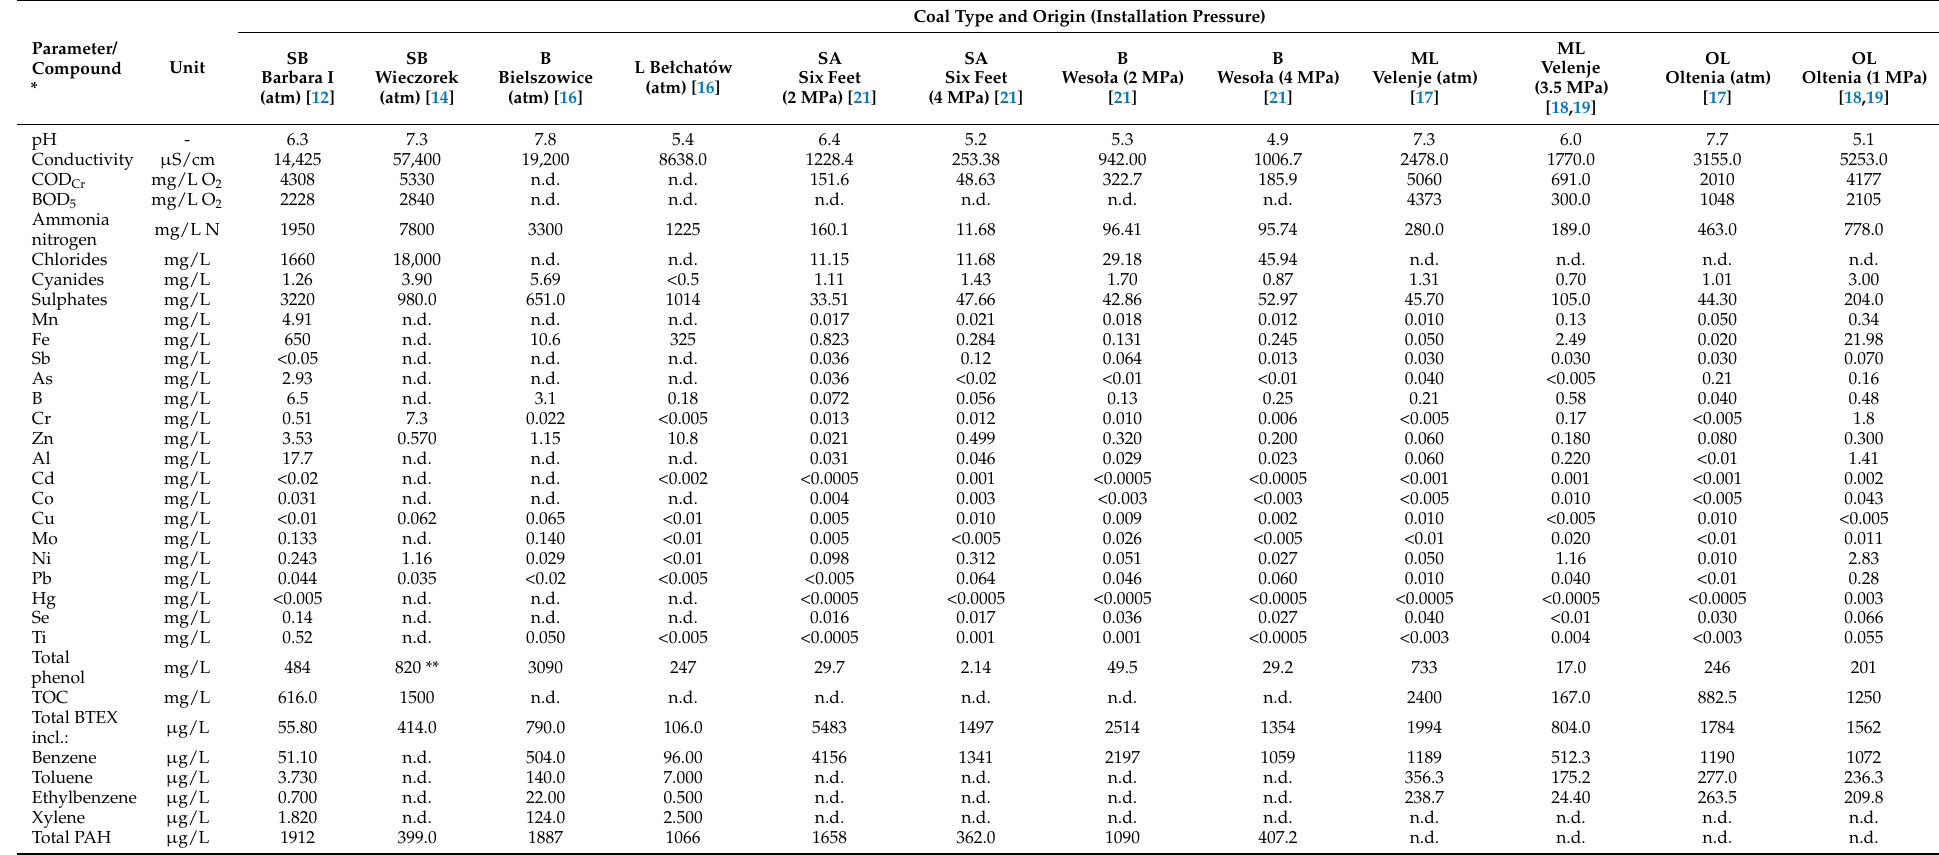
Table 4. Composition of the UCG post-processing wastewater from selected experiments conducted in the Central Mining